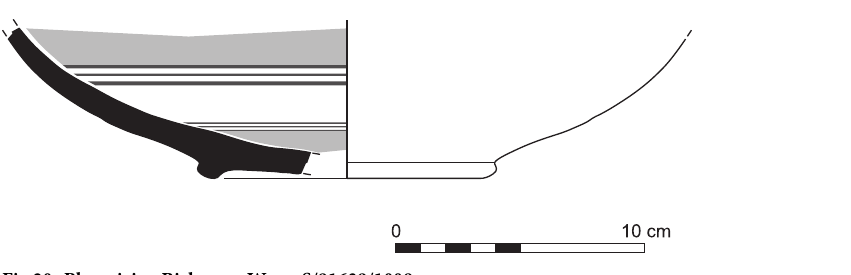
Fig 20. Phoenician Bichrome Ware: